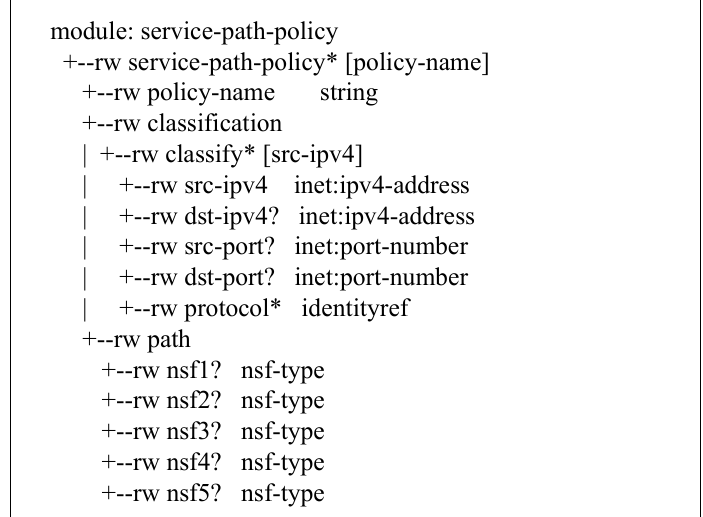
Table 1. Advanced Path Policy Data Model.